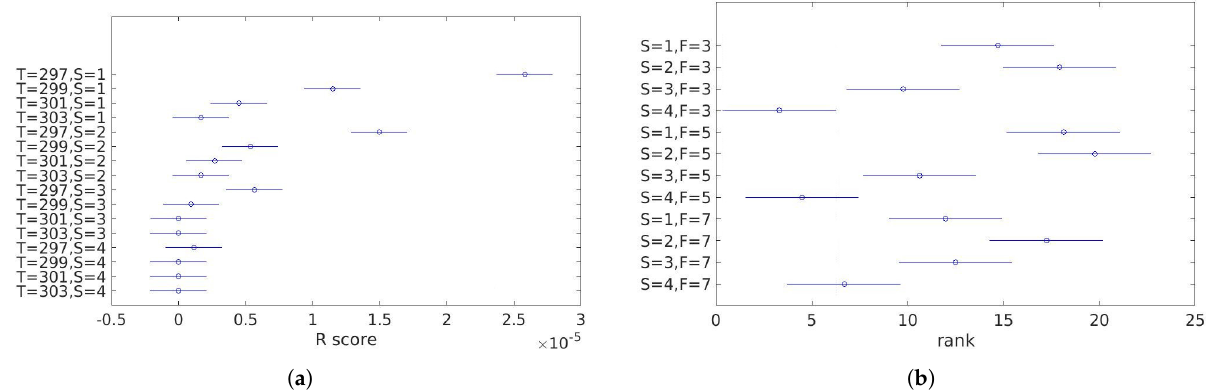
Figure 8. Multiple comparisons of ( a ) R score for the temperature and the trace size, ( b ) ranking for trace and the filter size. T stands for temperature, S for the trace size and F for the filter size.